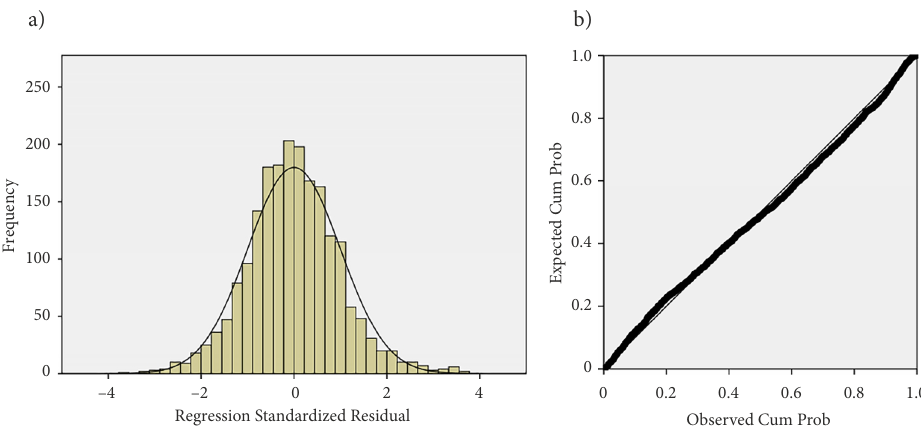
Figure 14. Normality test of residuals: a – residual histogram; b – the P-P probability plot